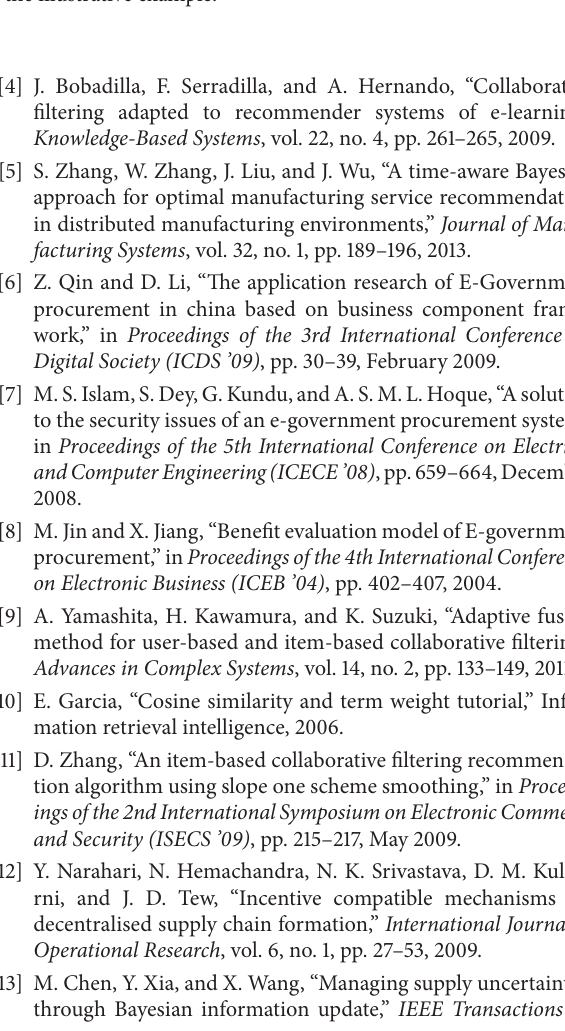
Figure 6: The search results of the illustrative